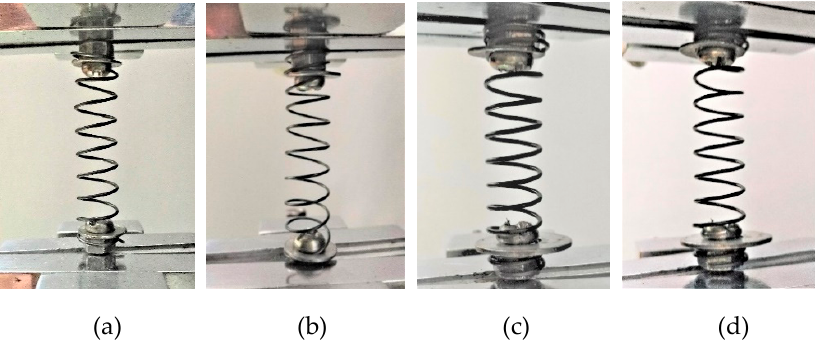
Figure 8. Tension tests of the SMA helical spring specimens: ( a ) SMA-S1; ( b ) SMA-S2; ( c ) SMA-S3; ( d ) SMA-S4.